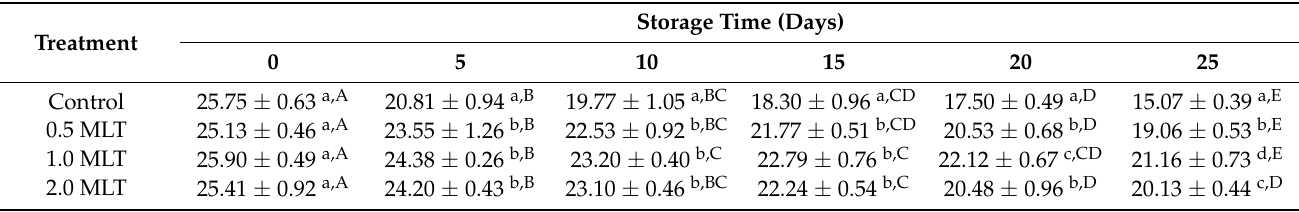
Table 3. Effect of melatonin treatment on chlorophyll content (mg/Kg fresh weight) of green asparagus during 25 days of storage at 4 ◦ C and 90% relative